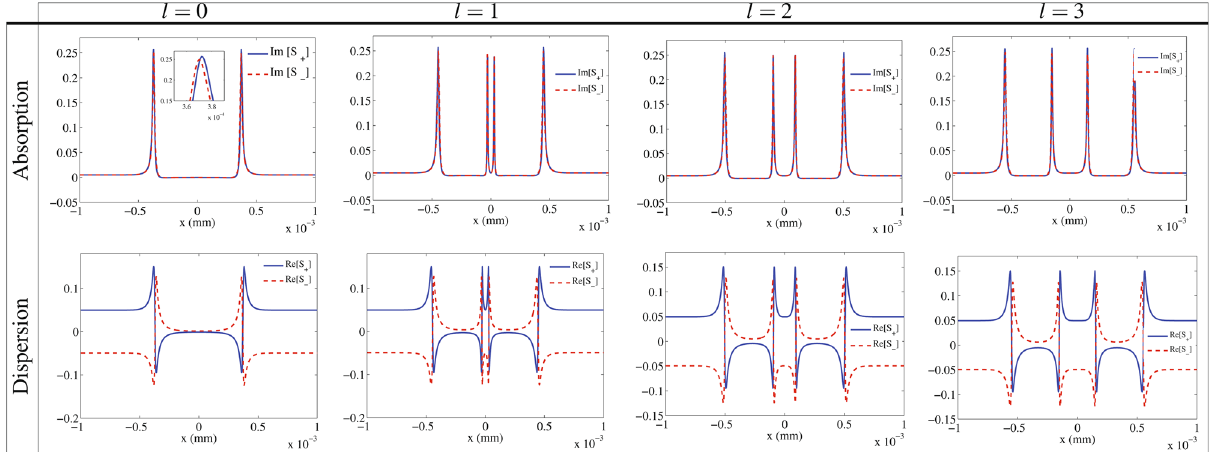
Figure 3. The Absorption (first row) and dispersion (second tow) of the right-(solid) and left-(dashed) circular components of the linearly polarized probe field in one dimension ( x ). The used parameters are those taken in Fig. 2.